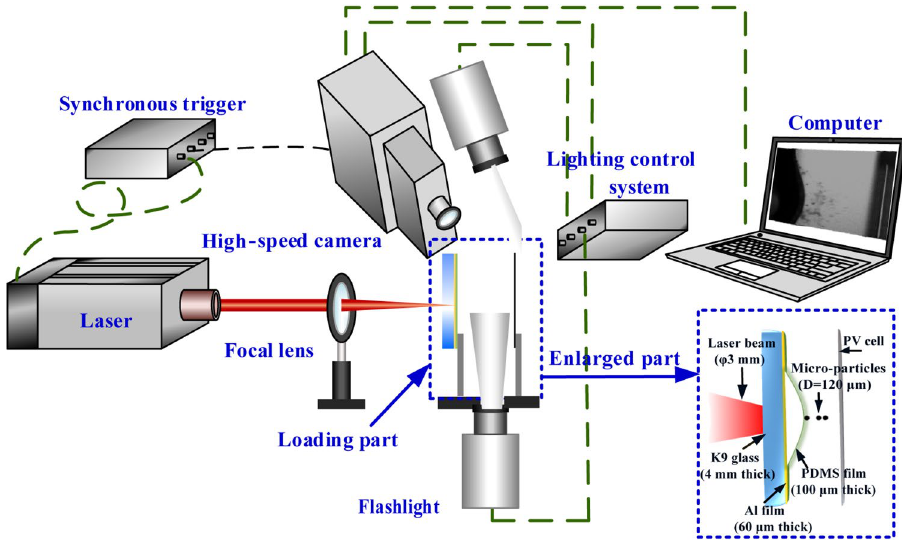
Figure 9. Schematic of the laser-shock induced particles impact on PV cells.